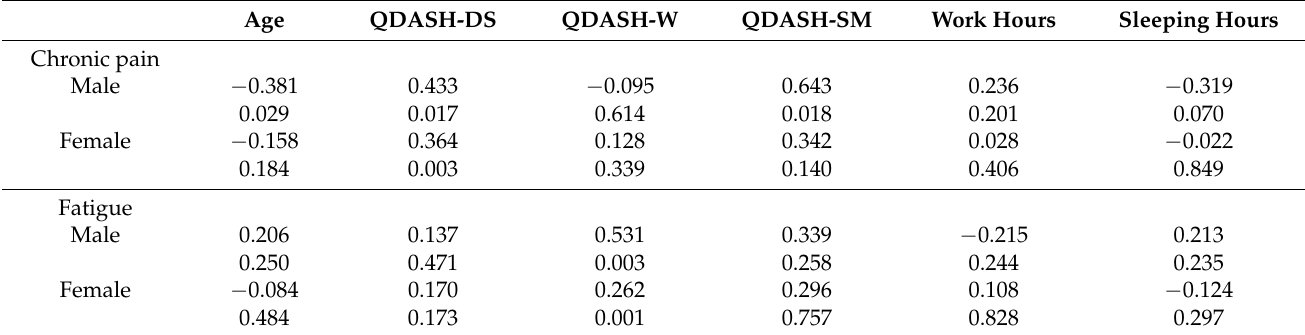
Table 6. Partial correlation coefficient of chronic pain and fatigue in males and females (both after adjusting for chronic pain and fatigue). Partial correlation coefficients (upper) and p -value (lower) of chronic pain and fatigue in males and females (both after adjusted pain and